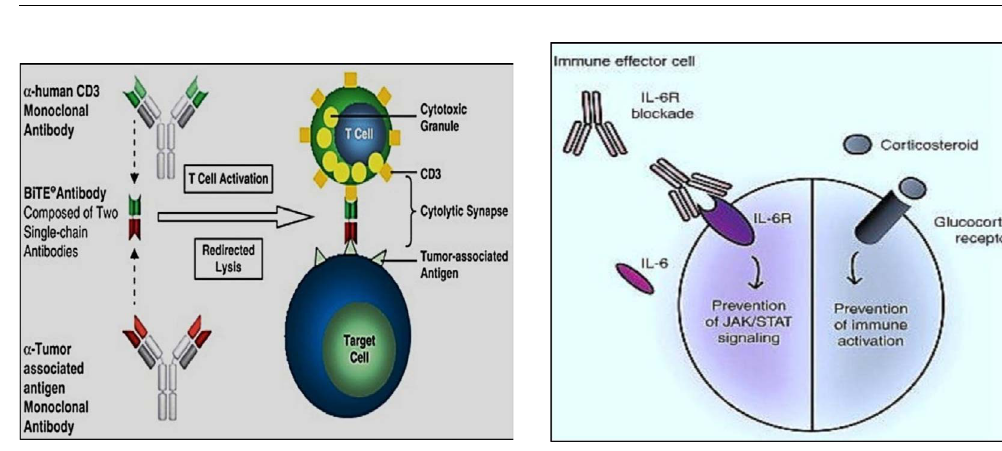
Fig. 5. Action of IL-6 blockers and corticosteroids